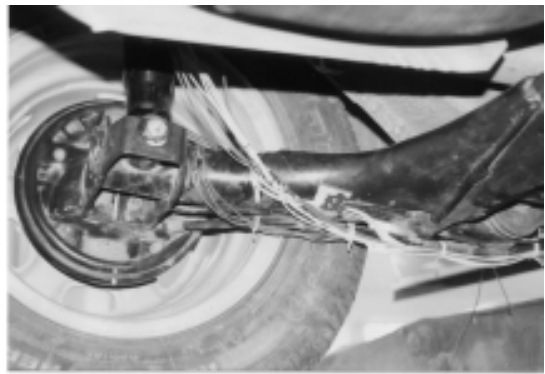
Fig. 6. Acceleration sensors and strain gauges for real road tests of the rear absorber and suspension on the left of the